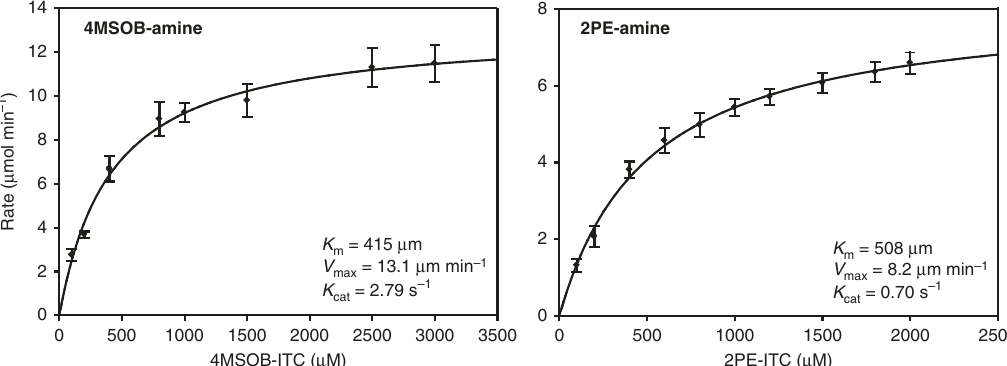
Fig. 4 Enzyme kinetic analyses of heterologously expressed SsSaxA with 4MSOB-ITC and 2PE-ITC. 4MSOB-amine was analyzed as its FMOC ( fl uorenylmethoxycarbonyl chloride) derivative to avoid signal quenching by the buffer. Products in each reaction were measured 5 min after the enzyme was added. Data represent mean ± SEM ( n = 3 independent reactions). 4MSOB-ITC, 4-methylsul fi nylbutyl isothiocyanate; 4MSOB-amine,